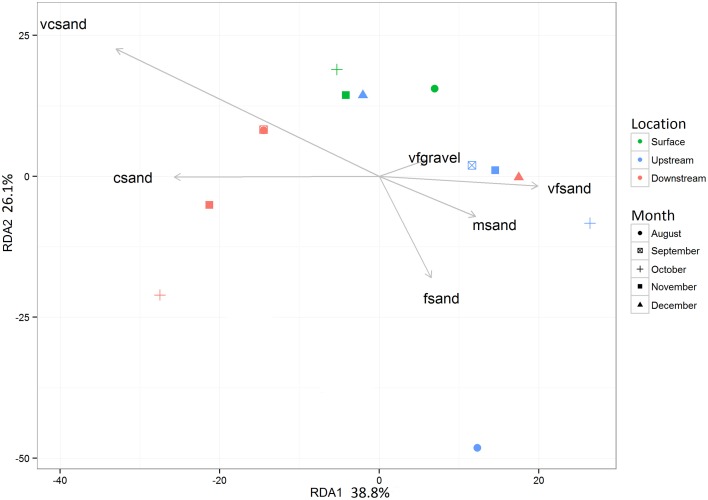
Redundancy analysis (RDA) of the culled OTU dataset as a function of the grain size analysis from the G2SD package gran_stat function output (Gallon and Fournier, 2013). Significance of each RDA axis was calculated with the RDAsignificance function from the BiodiversityR package for R (Kindt, 2014).